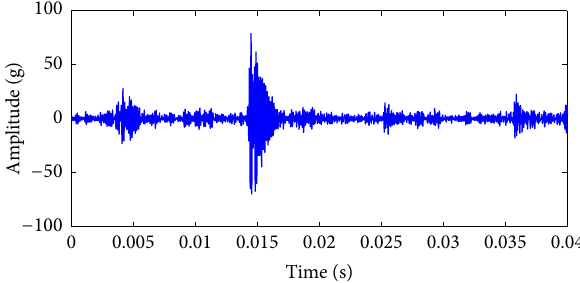
Figure 14: The band pass filter result of cylinder block vibration signal measured at 2800 rpm